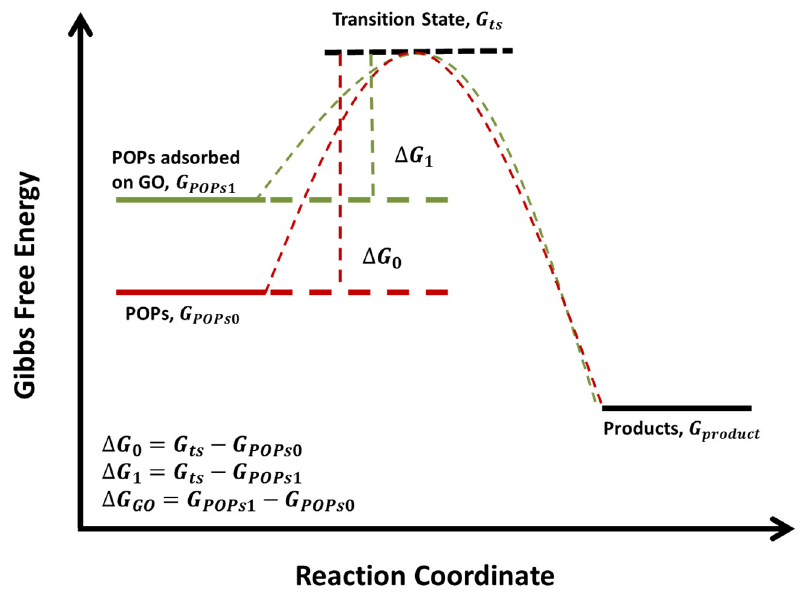
Figure 3. The conceptual diagram of the Gibbs free energy profile versus the reaction coordinate. Table 4. Gibbs free energy of POPs